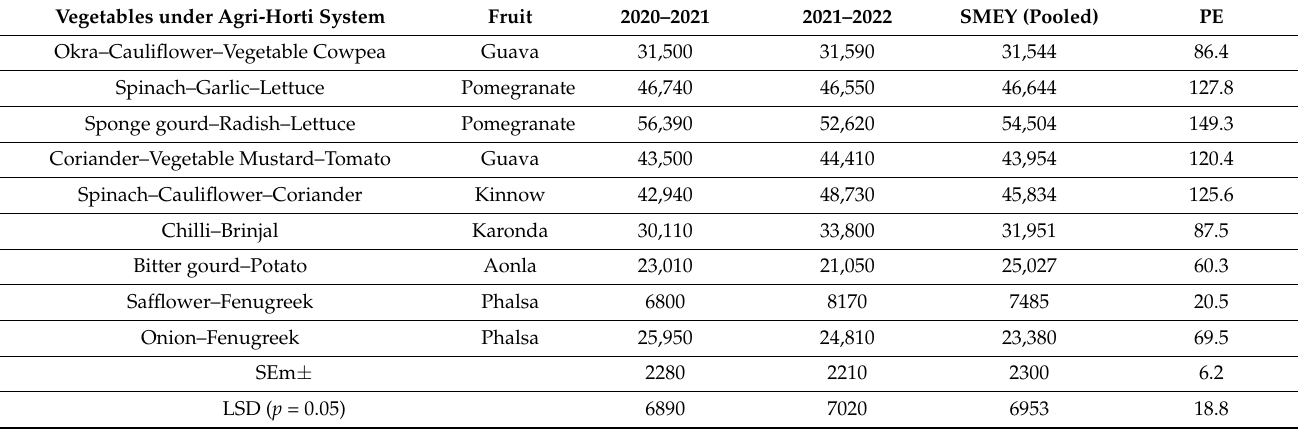
Table 6. System maize equivalent yield (kg/ha) and production efficiency (kg/ha/day) of the agri–horti